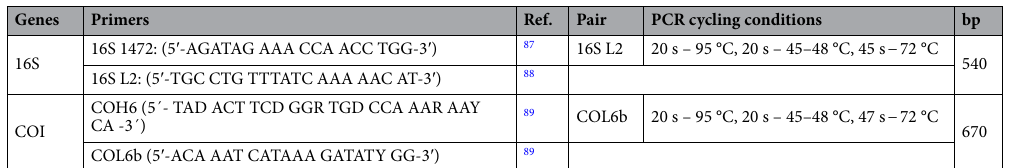
rostrum in portunids) to posterior margin of cephalothorax; and cephalothorax width (CW), measured as the cephalothorax maximum width (mesobranchial regions). For the megalopas dorsal view, only the left pereiopods were drawn since one of the right pereiopods was used for molecular analyzes. Descriptions were arranged according to the standards proposed by Clark et al. 83 and Clark & Cuesta 84 , and setal terminology follows the classification by Landeira et al. 85 . A detailed description of Achelous floridanus is provided while the others portunids descriptions are summarized in the Table 2. For Xanthidae and Pseudorhom- bilidae families, the specie of Neoliomera cerasinus is described in detail and the others xanthoids descriptions are summarized in the Table 3.